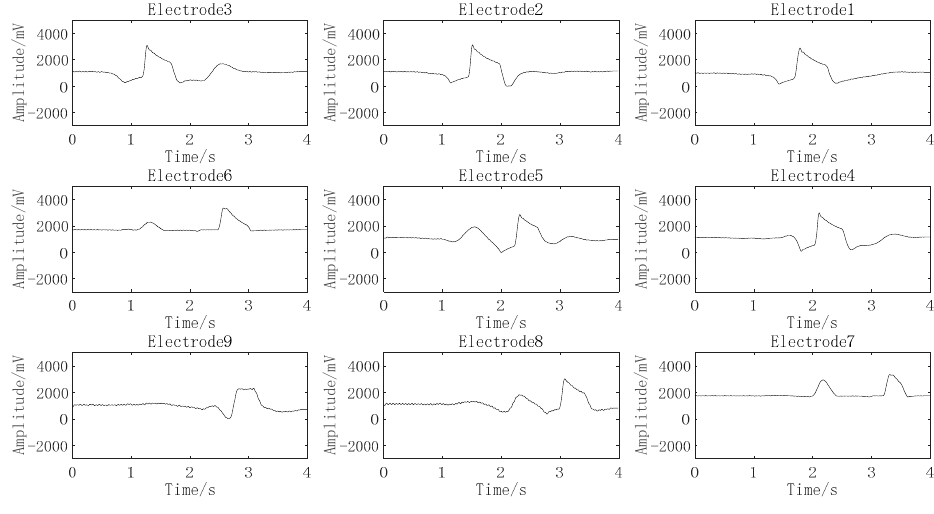
Figure 10. Signals generated by digit 2. Table 2. Time sequence of signals generated by digits 2, 3, 5, and 6.